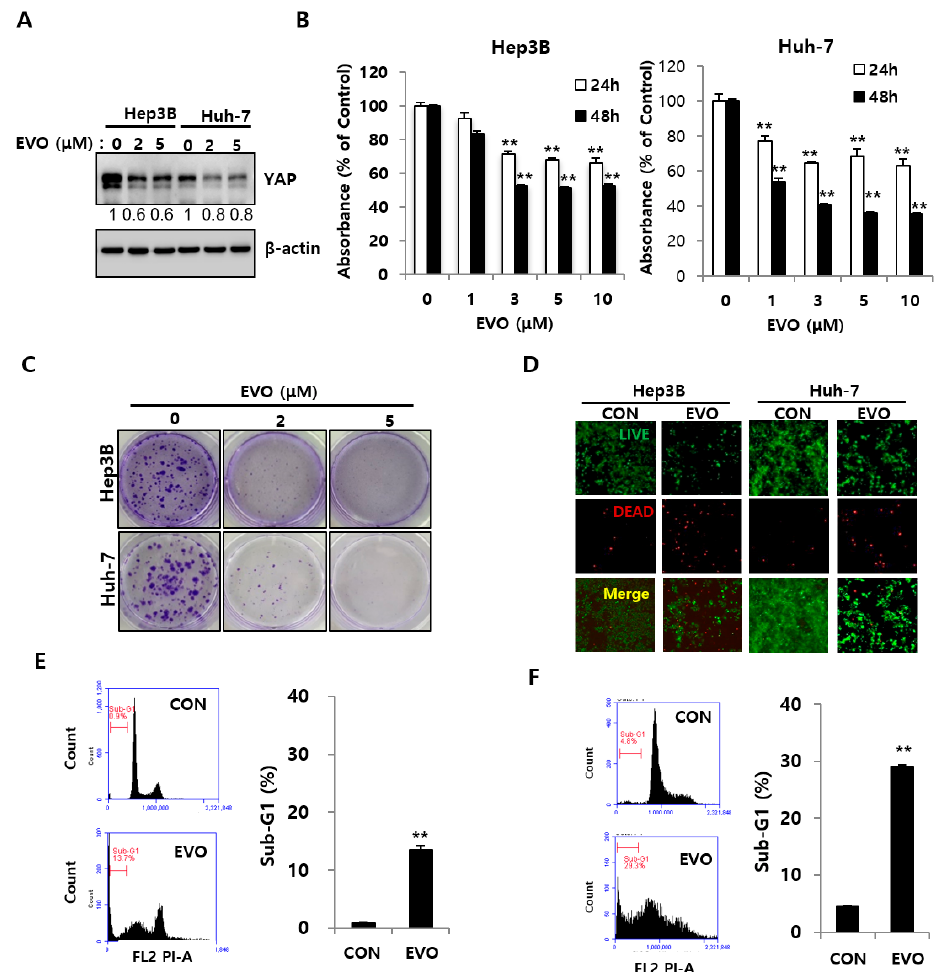
Figure 3. YAP regulation and cell death by evodiamine. ( A ) Hep3B and Huh-7 cells were treated with the indicated concentration of evodiamine for 48 h, followed by immunoblotting analysis with YAP and β -actin antibodies. The loading control was β -actin. ( B ) Hep3B and Huh-7 cells were treated with the indicated concentration of evodiamine (EVO). Cell growth was measured using a MTT assay at 24 h and 48 h, with error bars representing S.D. (versus control, ** p < 0.01) ( C ) Hep3B and Huh-7 cells were treated with the indicated concentration of evodiamine (EVO) for 48 h, which was then changed with fresh media without EVO and incubated for ten days. ( D ) Hep3B and Huh-7 cells were treated with 5 µ M EVO for 48 h, followed by live/dead analysis with calcein-AM (live) and PI (dead). Images were taken by fluorescence microscopy. Scale bar = 200 µ M. ( E , F ) Hep3B ( E ) and Huh-7 ( F ) cells were treated with 5 µ M EVO for 48 h, followed by cell cycle analysis by flow cytometry. The Sub-G1 is summarized in the histogram, with error bars representing S.D. (versus Control, ** p < 0.01). The numbers under the western blot indicate the intensity of the band. CON, control; EVO, evodiamine.